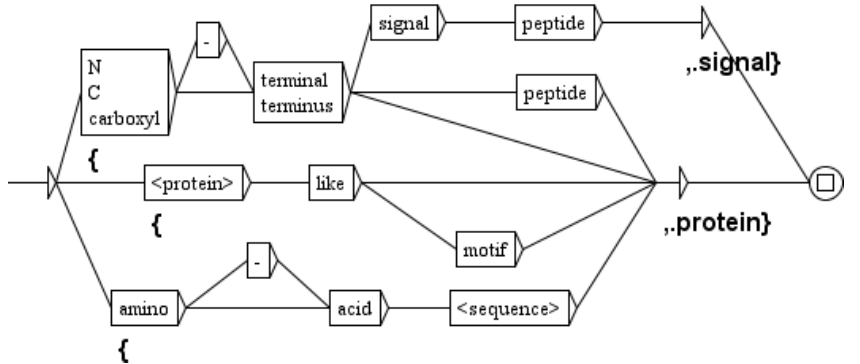
Figure 7. The graph to distinguish proteins from